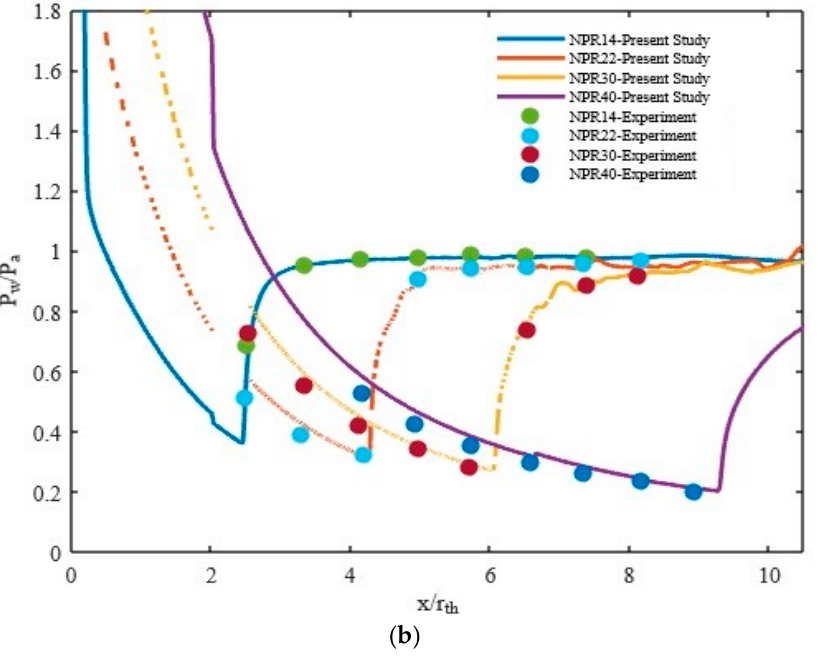
Figure 3. Wall pressure distribution: ( a ) at NPR 14 for different viscous models; ( b ) comparison of simulation result with the experimental result [39] for different NPRs.